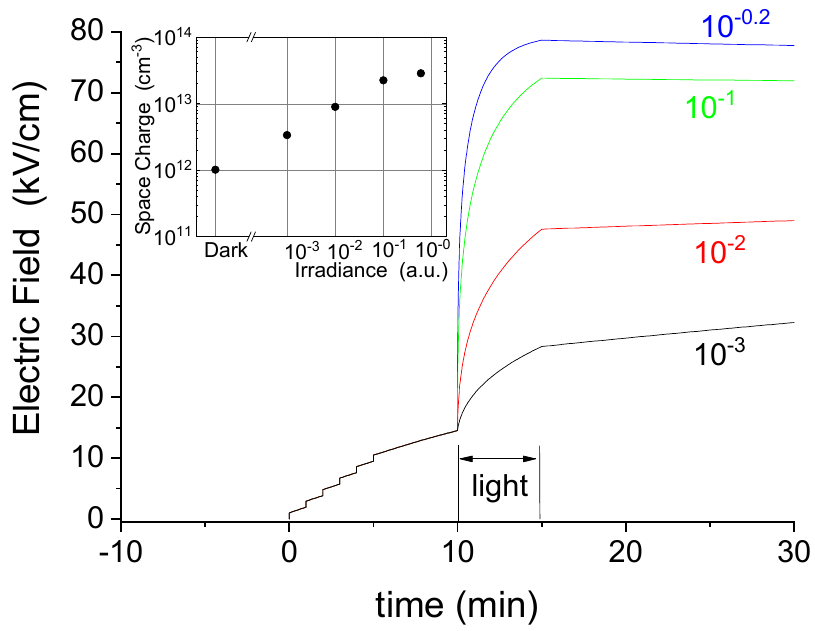
Figure 6. Simulated electric field transients at the anode under different optical irradiances. In the inset, the space charge computed at the anode under dark conditions (just before light) and under optical excitation, just before switching it off. The temperature was 40 °C. Results can be directly compared with the experimental results in Figure 4.